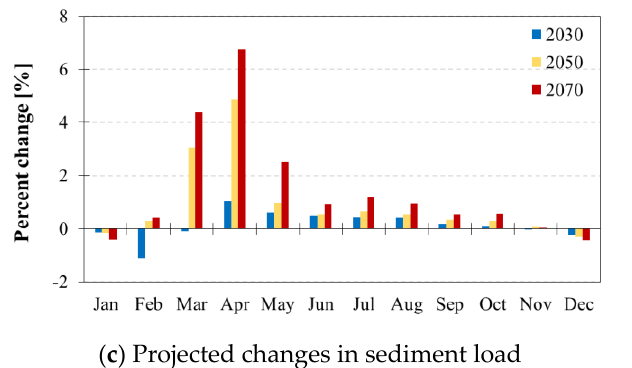
Figure 7. Projected changes in ( a ) water balance components, ( b ) streamflow, and ( c ) sediment load under the influences of changing LUC scenarios.